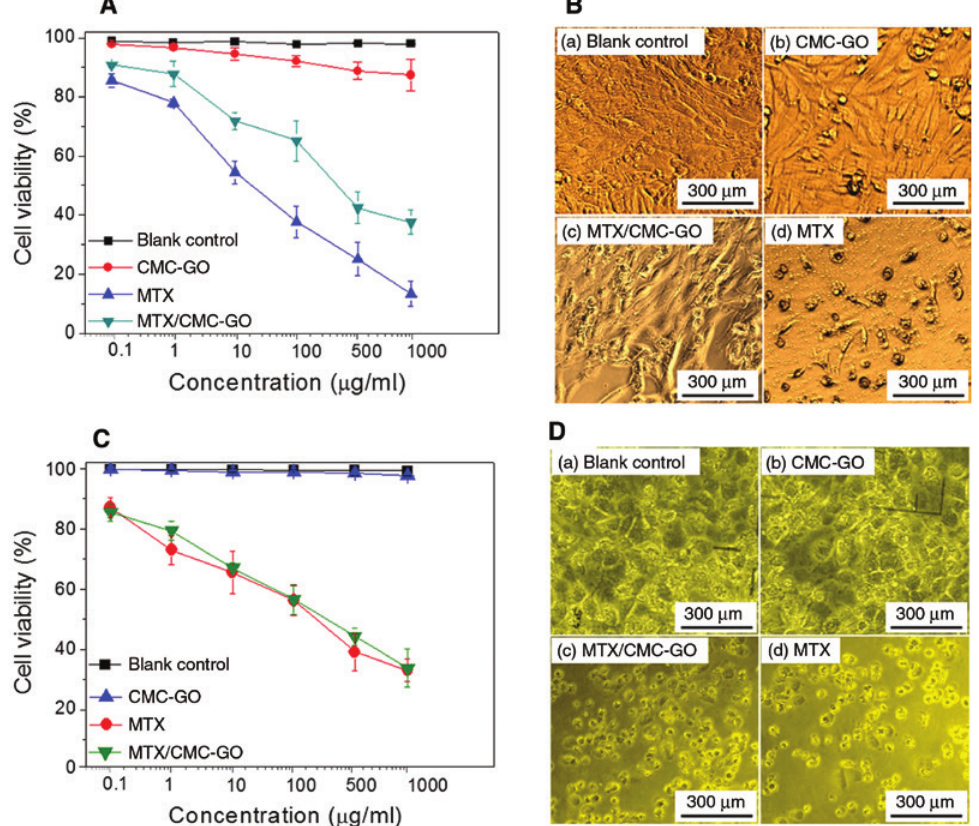
Figure 4: (A) The viability of NIH-3T3 cells after treatment with no stimulus (blank control), CMC-GO, MTX/CMC-GO and MTX for 24 h. (B) Photo of microscopy depict NIH-3T3 cells incubated for 24 h with no stimulus (blank control), CMC-GO, MTX/CMC-GO and MTX (100 μ g/ml). (C) The viability of HT-29 cells after treatment with no stimulus (blank control), CMC-GO, MTX/CMC-GO and MTX for 24 h. (D) Photo of microscopy depict HT-29 cells incubated for 24 h with no stimulus (blank control), CMC-GO, MTX/CMC-GO and MTX (100 μ